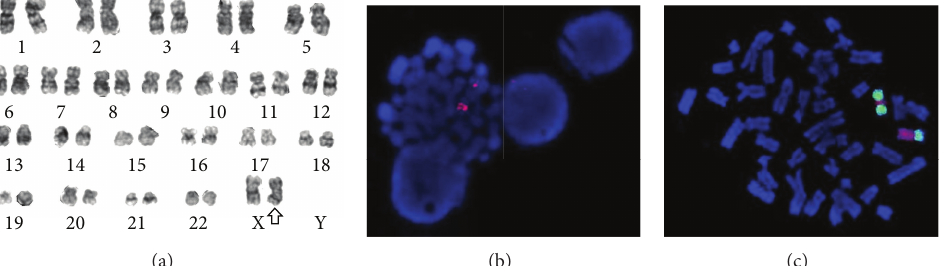
Figure 1: (a) G-banded karyotype of the bone marrow cells showed a 46,X,idic(X)(q13) [4] /46,XX [16] . The arrow indicates the isodicentric X chromosome. (b) FISH analysis in metaphase cell with CEP X probe showed two centromeres on the idic(X), red signals. (c) Hybridisation on metaphase cell with WCP Xp (green signal) and WCP Xq probes (red signal) showed a normal X chromosome and an idic(X) with a red signal (Xq) between two green signals (Xp).